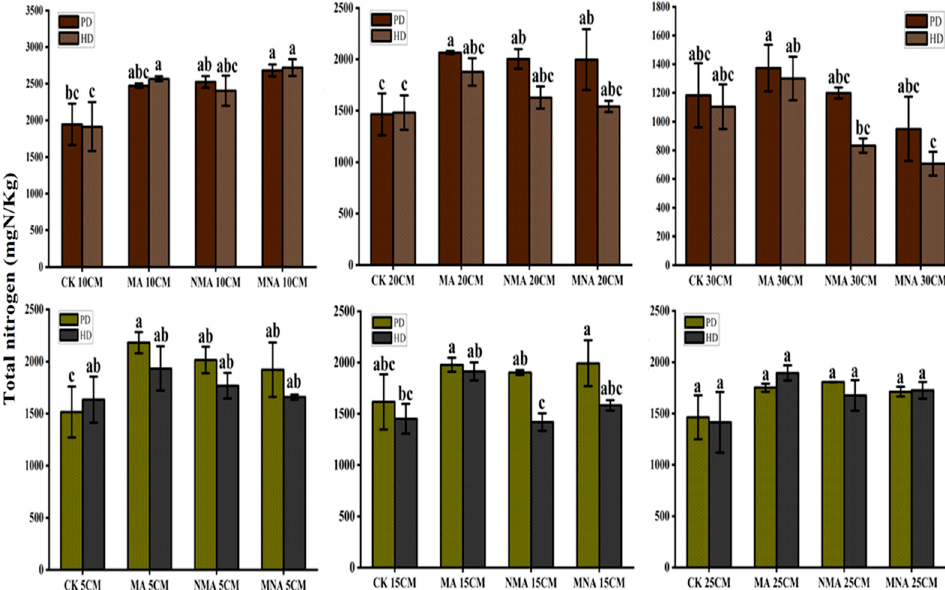
Figure 7. Effects of soil depth ( top row ) and distance from plant trunk ( bottom row ) on soil total nitrogen content. The bars are the standard error of the replications while the different letters on the bars indicate significant differences at p < 0.05.